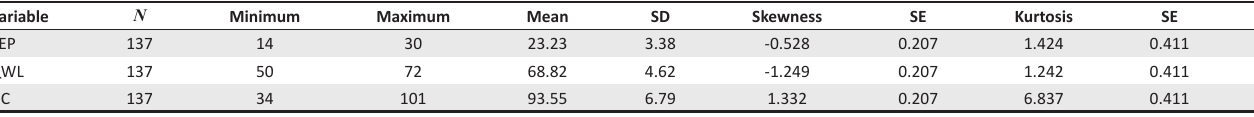
TABLE 2 : Summary of the means, standard deviation, skewness and kurtosis. Variable